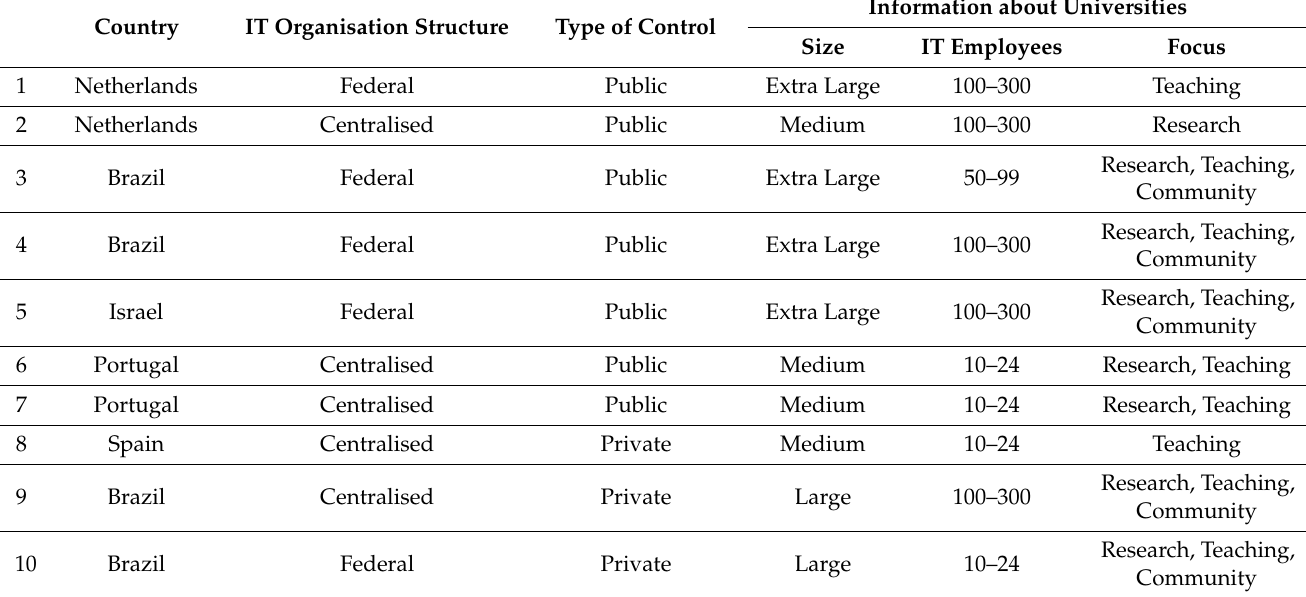
Table 2. Information about